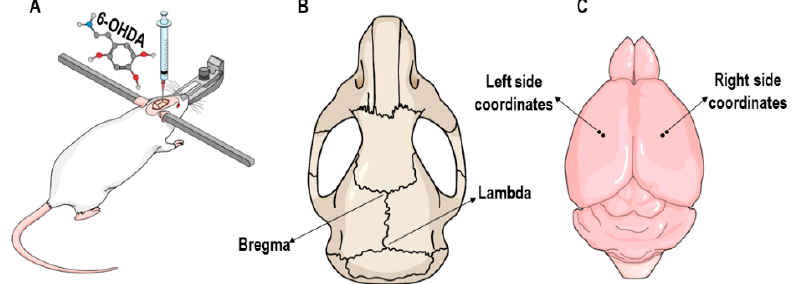
Figure 1. Schematic figure of the 6-hydroxydopamine (6-OHDA)-induced bilateral striatal lesion. ( A ) Animal fixed to stereotactic apparatus receiving injection of the neurotoxin by Hamilton syringe. ( B ) Rat skull, the arrows indicate the anthropometric points (lambda and bregma). ( C ) Rat brain, the arrows indicate the points referring to the stereotactic coordinates used for bilateral injection of 6-OHDA into the striatum. Picture created on the Mind the Graph platform (mindthegraph.com) under